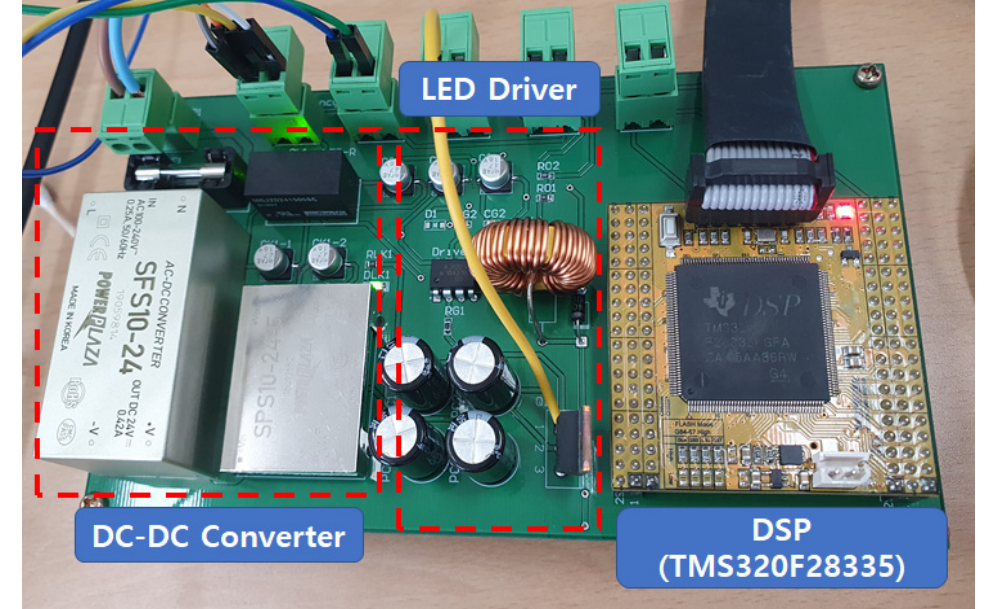
Figure 10. Proposed calibration algorithm control board.